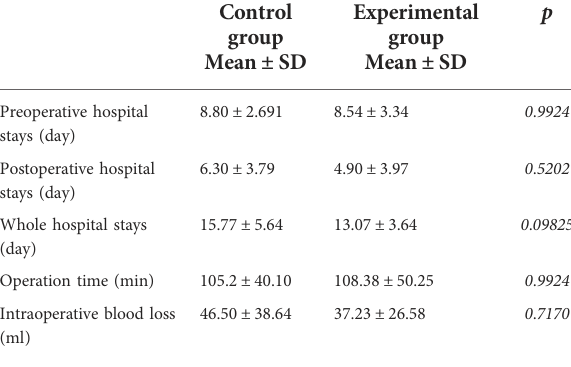
TABLE 2 Operation time, intraoperative blood loss, and length of hospital stays of trans-syndesmotic screw fi xation (control) group and deltoid ligament repair (experimental) group.